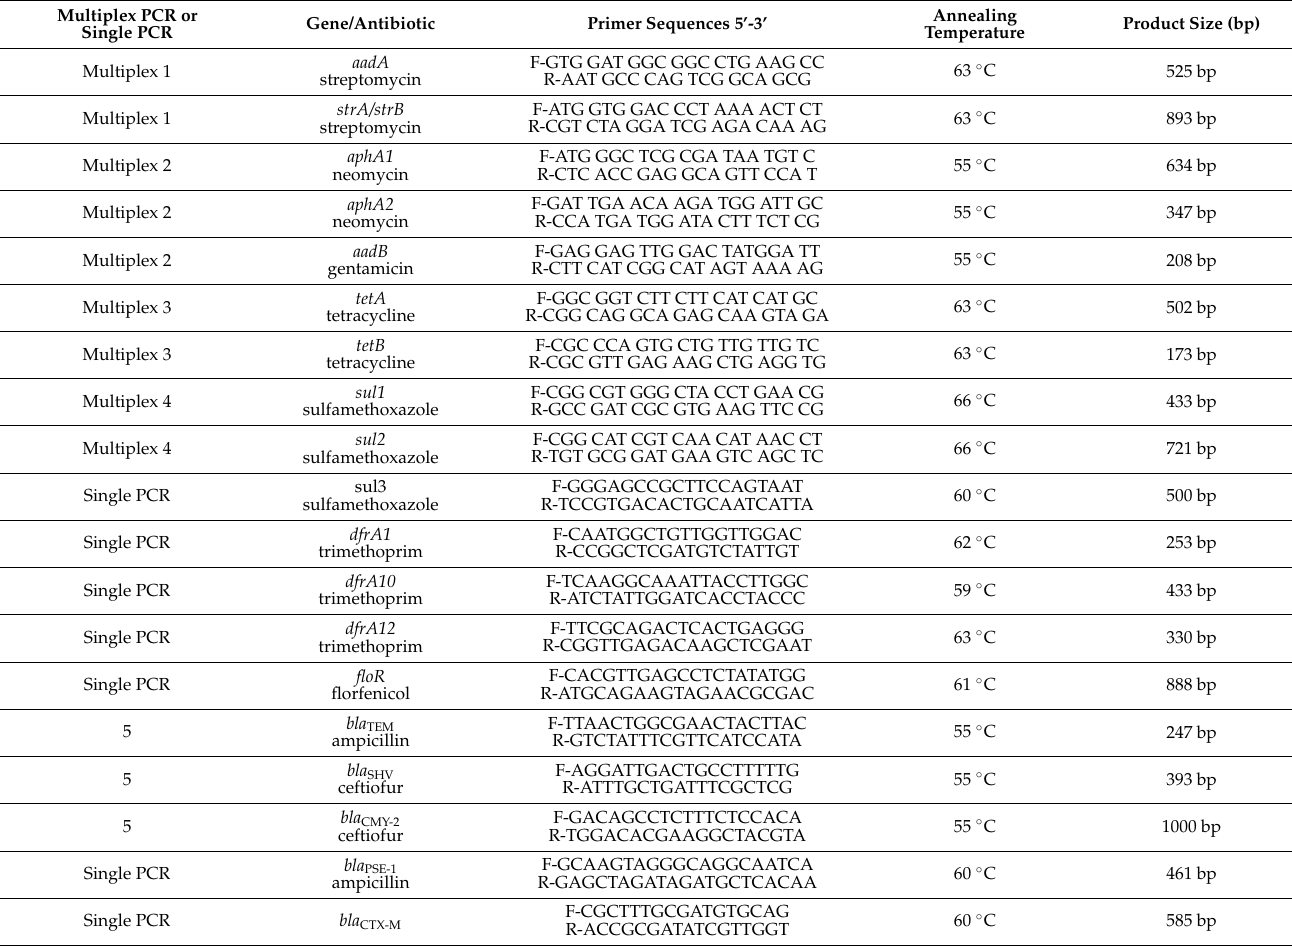
Table 4. Description of primer sets, annealing temperature and product size for the molecular gene identification